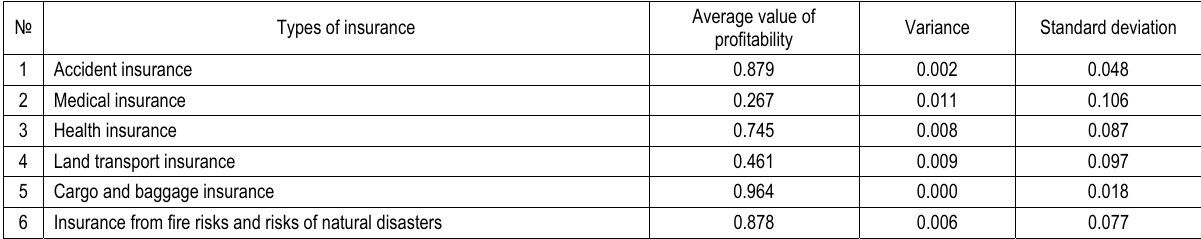
Table 4. Estimates of the average profitability and risk (standard deviation) according to the types of insurance